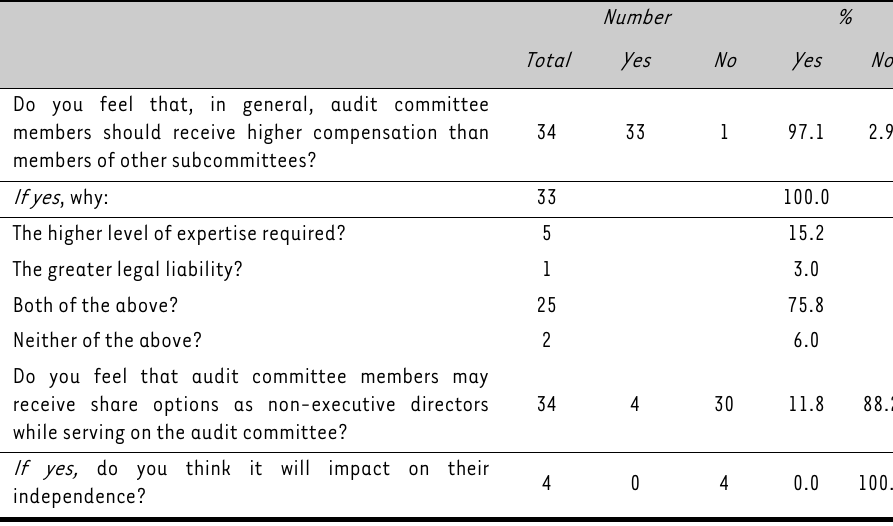
TABLE 6: Compensation of audit committee members